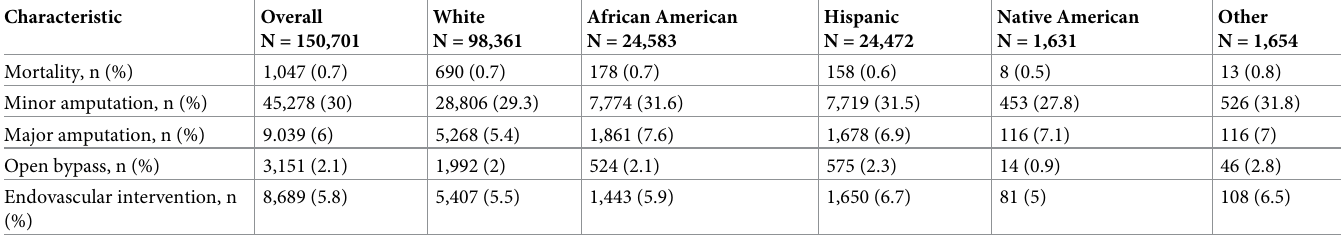
Table 2. Outcomes of patients with diabetic foot